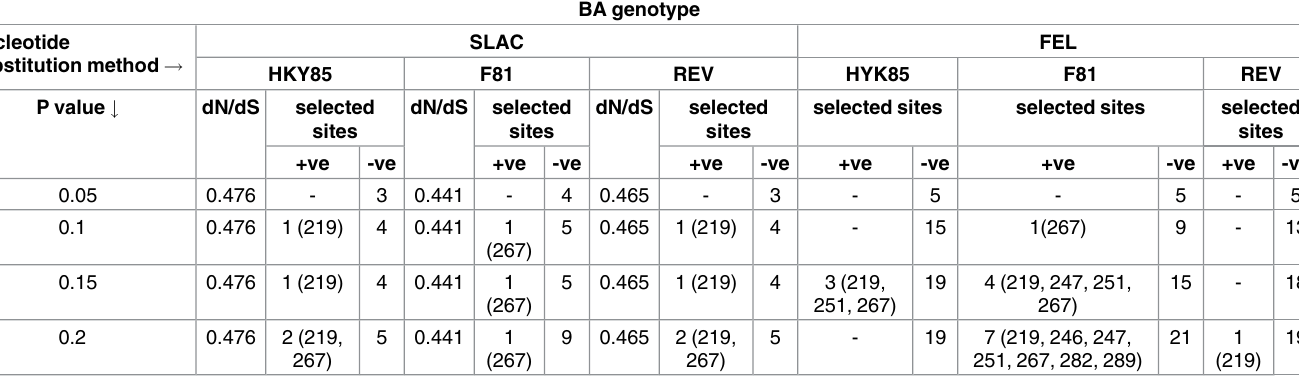
Table 5. Selection pressure analysis of the RSV BA genotype of the second hypervariable region of G protein gene using SLAC and FEL